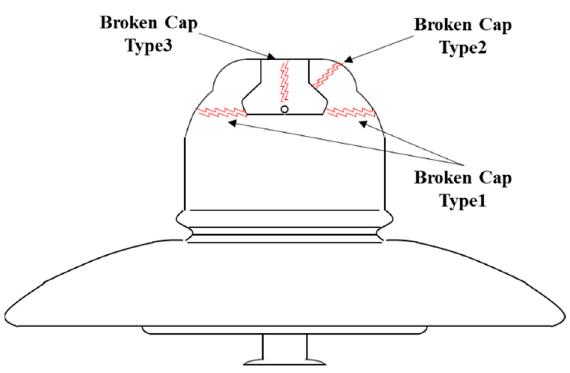
Figure 1. Porcelain insulator showing possible defects.